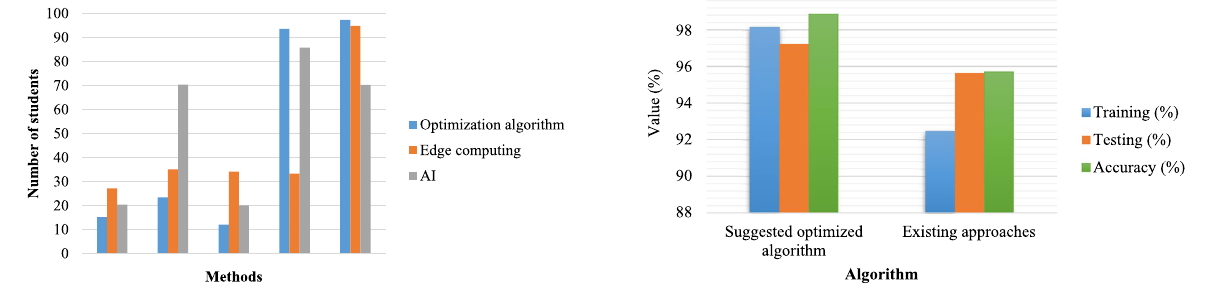
Fig. 14 Performance comparison in terms of training and testing